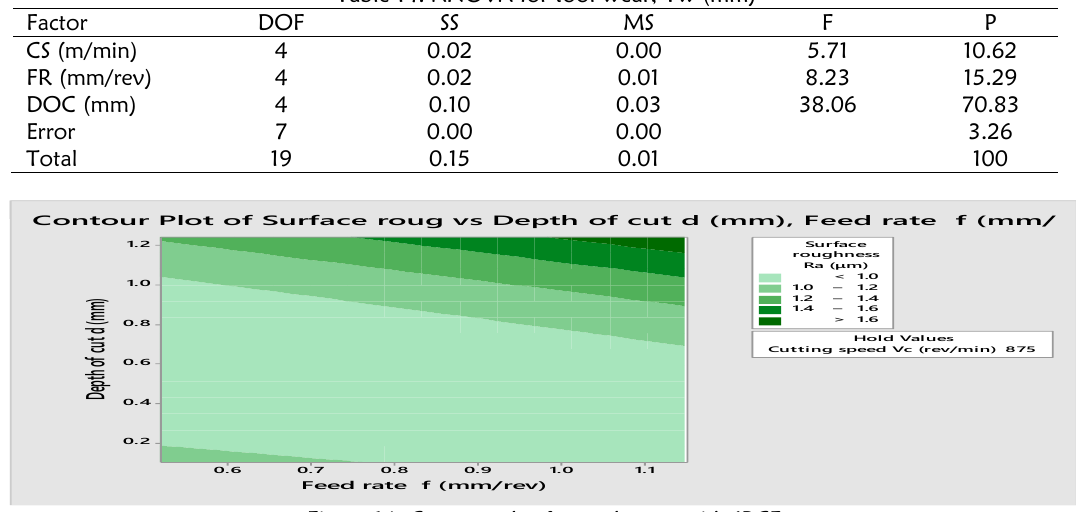
Figure 14: Contour plot for tool wear with